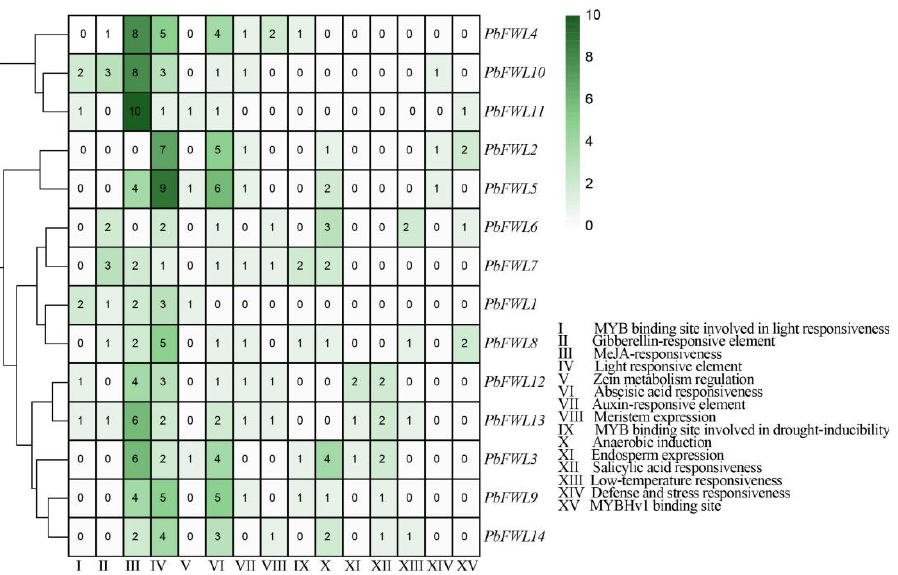
Figure 4. Schematic diagram of chromosome distribution and interchromosomal relationships of PbFWLs in pears. ( A ) The distribution pattern of PbFWLs in 9 pear chromosomes, where the chro- mosome number is indicated at the top of each chromosome. ( B ) The distribution pattern synteny analysis of fw2.2-like gene family of pear; the gray lines indicate all synteny blocks in the pear ge- nome, and the red lines indicate duplicated PbFWL gene pairs.